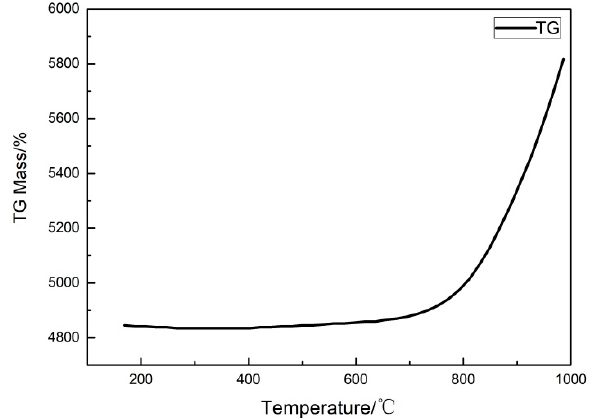
Figure 2. TG curve of porous Ti support.